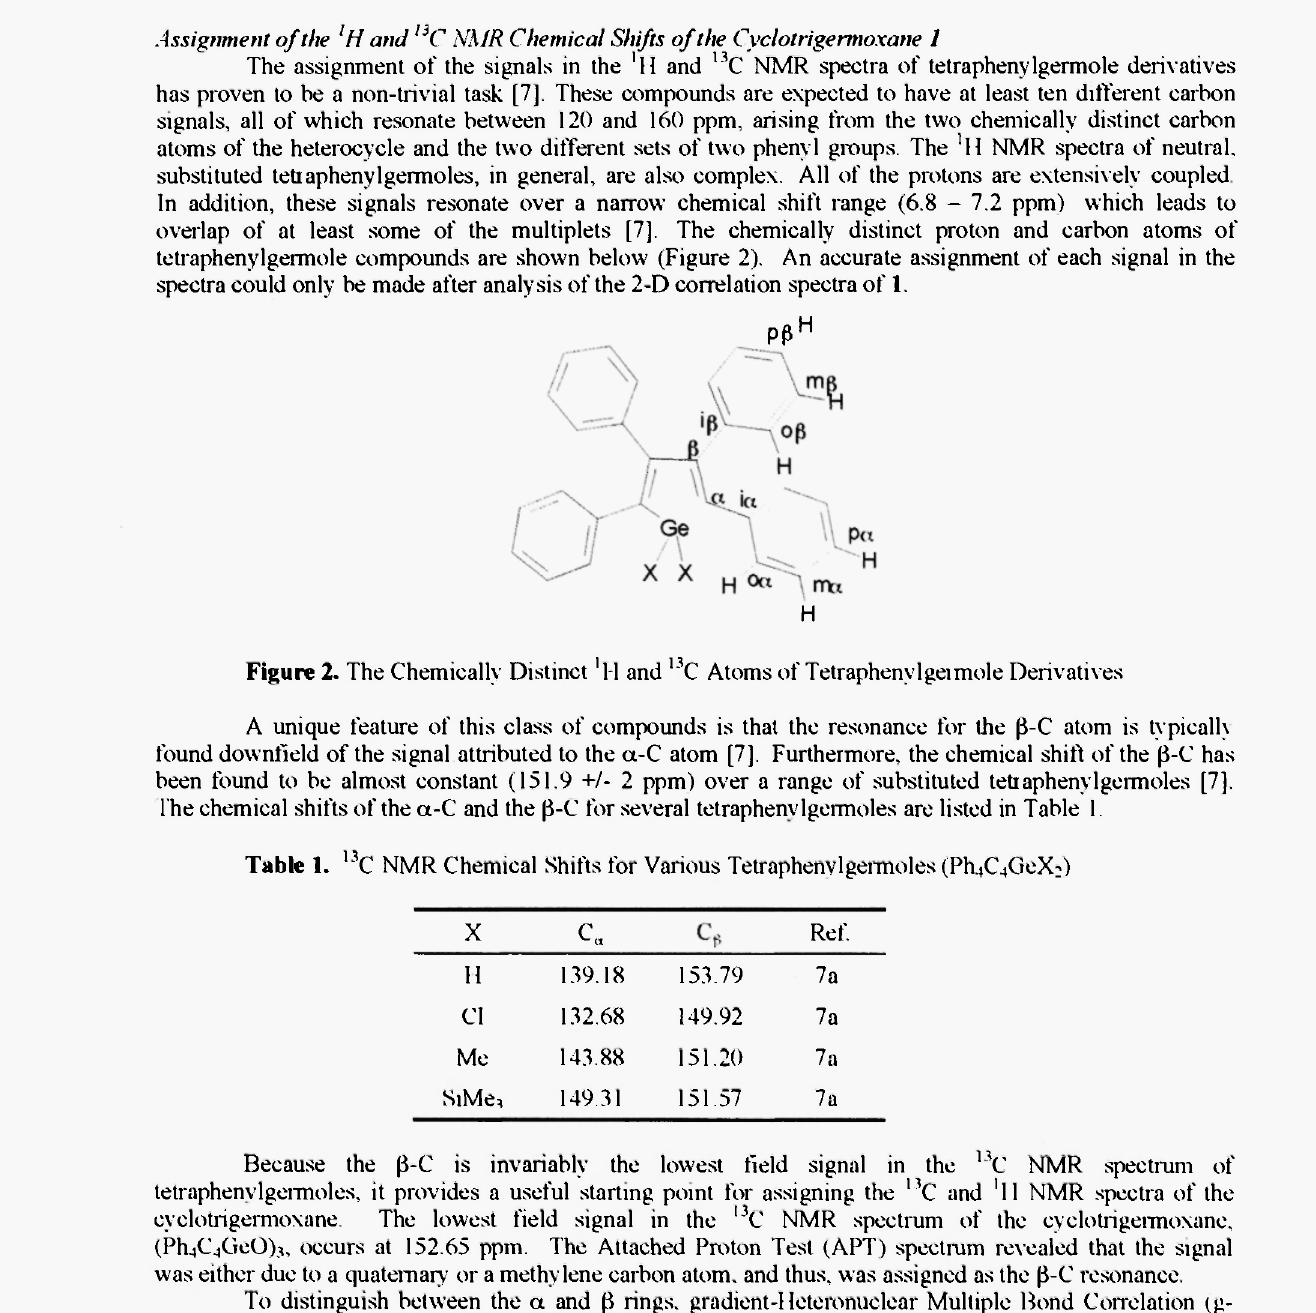
Table 1. 13 C NMR Chemical Shifts for Various Tetraphenvlgermoles (Ph,C,GeX : ) X c„